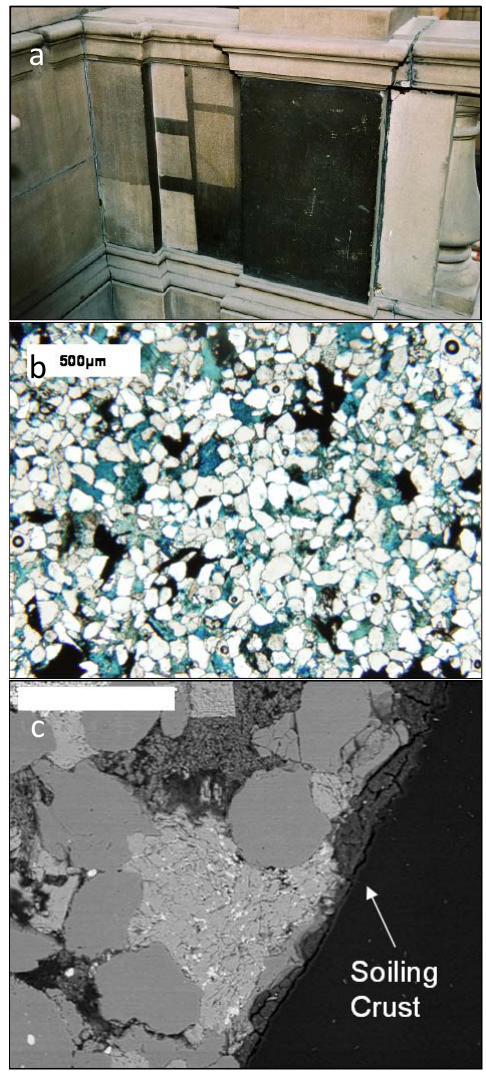
Figure 2. Examples of microscopy applied to the fundamental characterisation of building sandstone from the interior of the Kelvingrove Museum, Glasgow. a) Remaining panel of uncleaned stone, with cleaning test panels. b) PPL PLM image of a thin section of stone, porosity is filled with blue ‐ dyed epoxy resin. Textures and mineralogy can be readily described, and the stone classified. c) SEM ‐ BSE image showing a cross section of the soiled outer